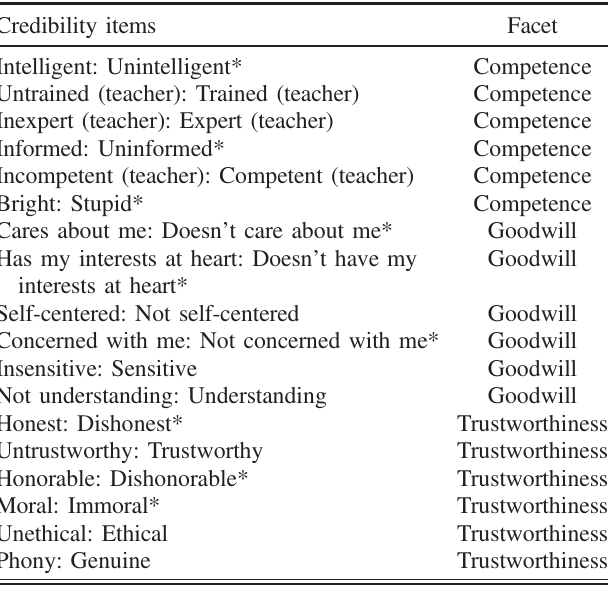
TABLE III. Items in the credibility instrument, on both the week 2 and week 14 surveys. Students selected a number ranging from 1 (the left item) to 7 (the right item) identifying where on the spectrum they would place their instructor. Each item is identified as belonging to the competence, goodwill, or trustworthiness facet. Item ordering was scrambled for presentation. Starred items are reverse coded.